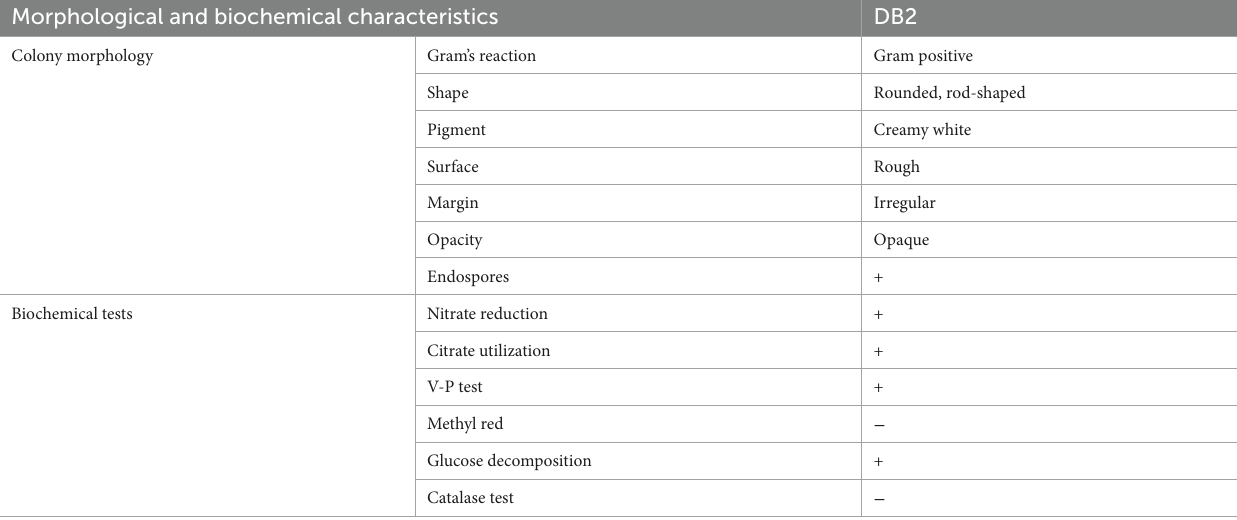
TABLE 1 Morphological and biochemical characteristics of DB2. Morphological and biochemical